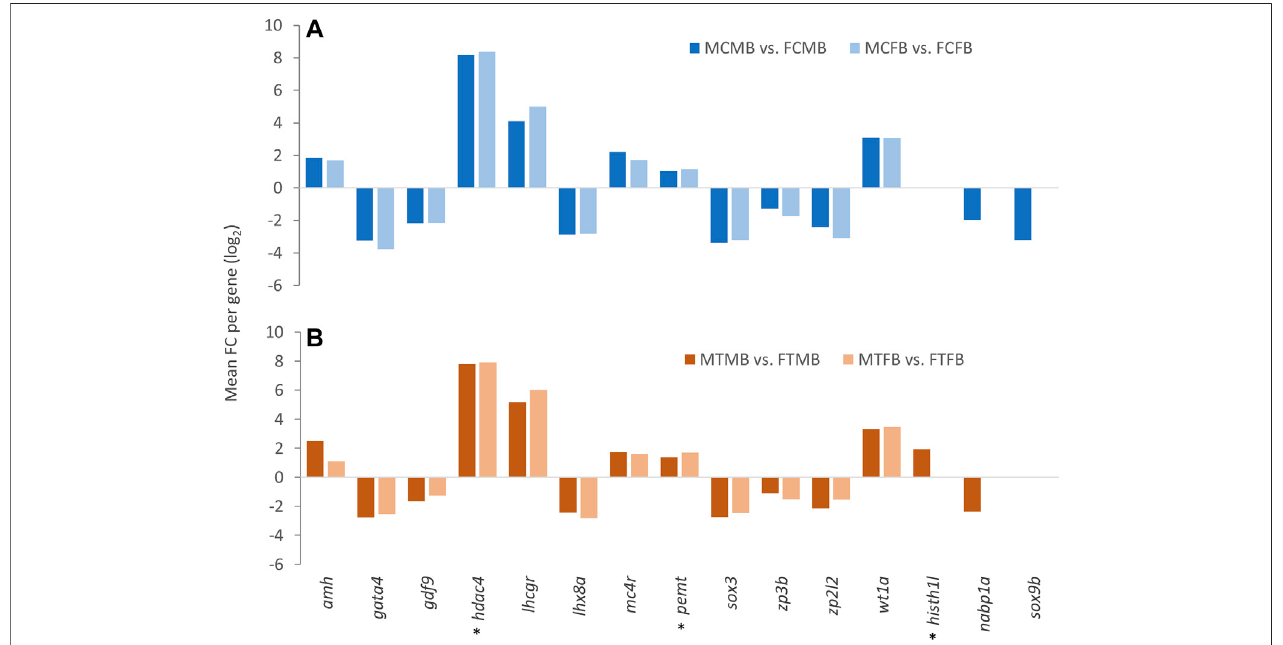
FIGURE 10 | Candidate genes associated with signi fi cantly differentially methylated promoters in male-biased and female-biased families. (A) male control male- biased versus female control male-biased (MCMB vs. FCMB); male control female-biased versus female control female-biased (MCFB vs. FCFB). (B) male treatment male-biasedversusfemaletreatmentmale-biased(MTMBvs.FTMB);maletreatmentfemale-biasedversusfemaletreatmentfemale-biased(MTFBvs.FTFB).The x -axis represents the candidate genes and the y -axis indicates mean fold change (log 2 FC) per gene. Genes involved in epigenetic mechanisms are marked with an asterisk (*). Other genes are reproduction-related